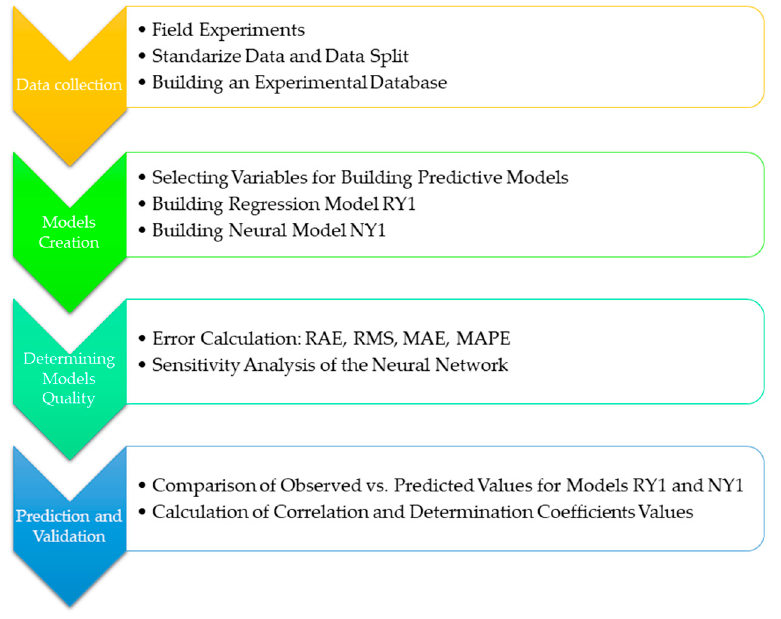
Figure 2. Flowchart of the paper framework.